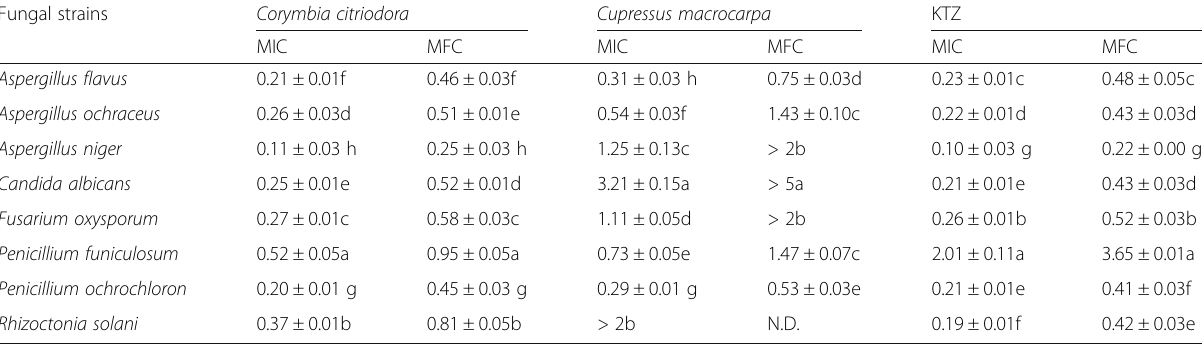
Table 3 Minimum inhibitory concentration (MIC) and fungicidal concentration (MFC) of different leaf extracts (mg/mL) of Corymbia citriodora and Cupressus macrocarpa